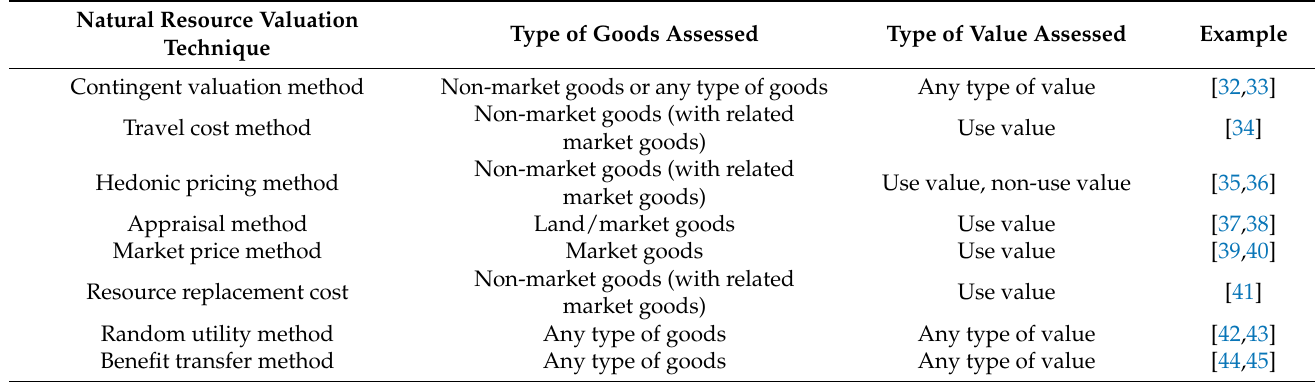
Table 1. Methods and techniques for natural resource